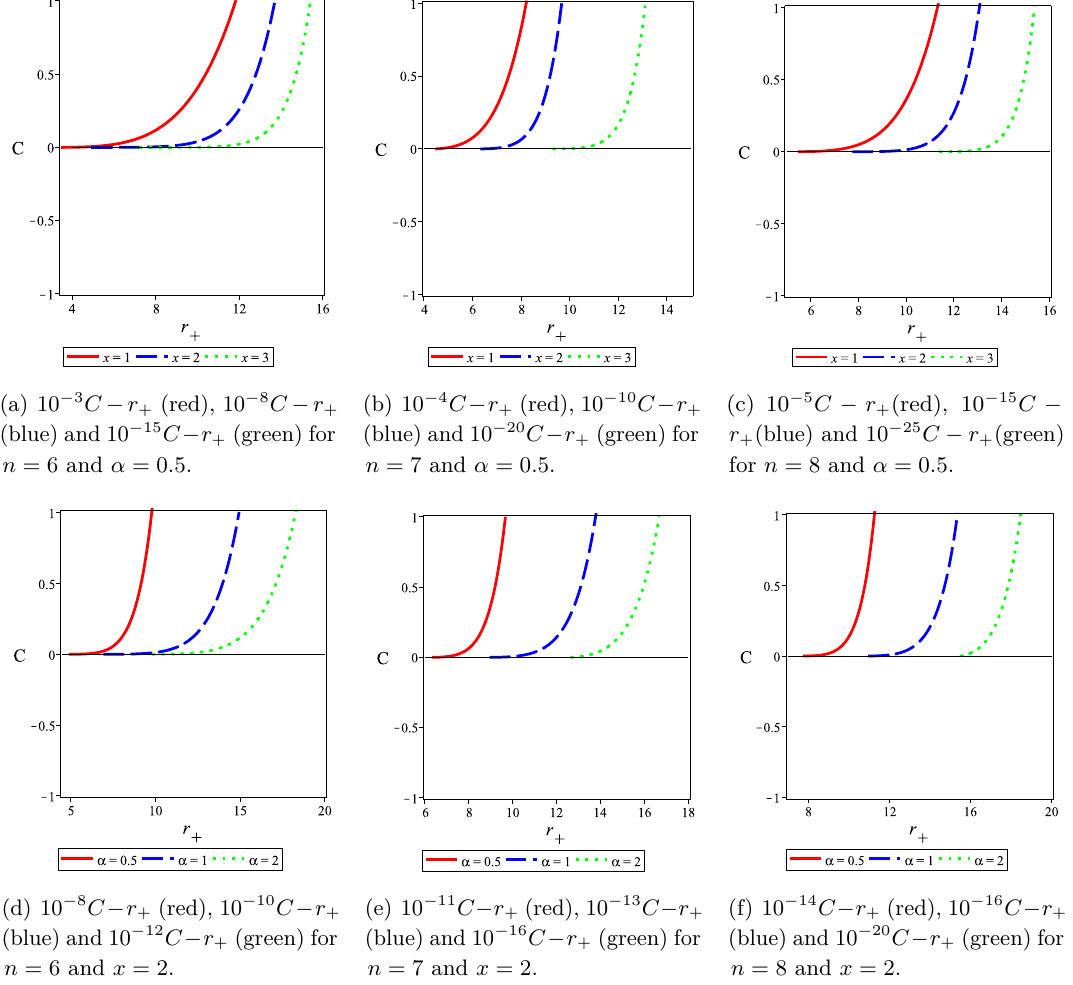
Figure 10 . Behavior of the heat capacity versus r + for G = 1 and for “ + ” sign